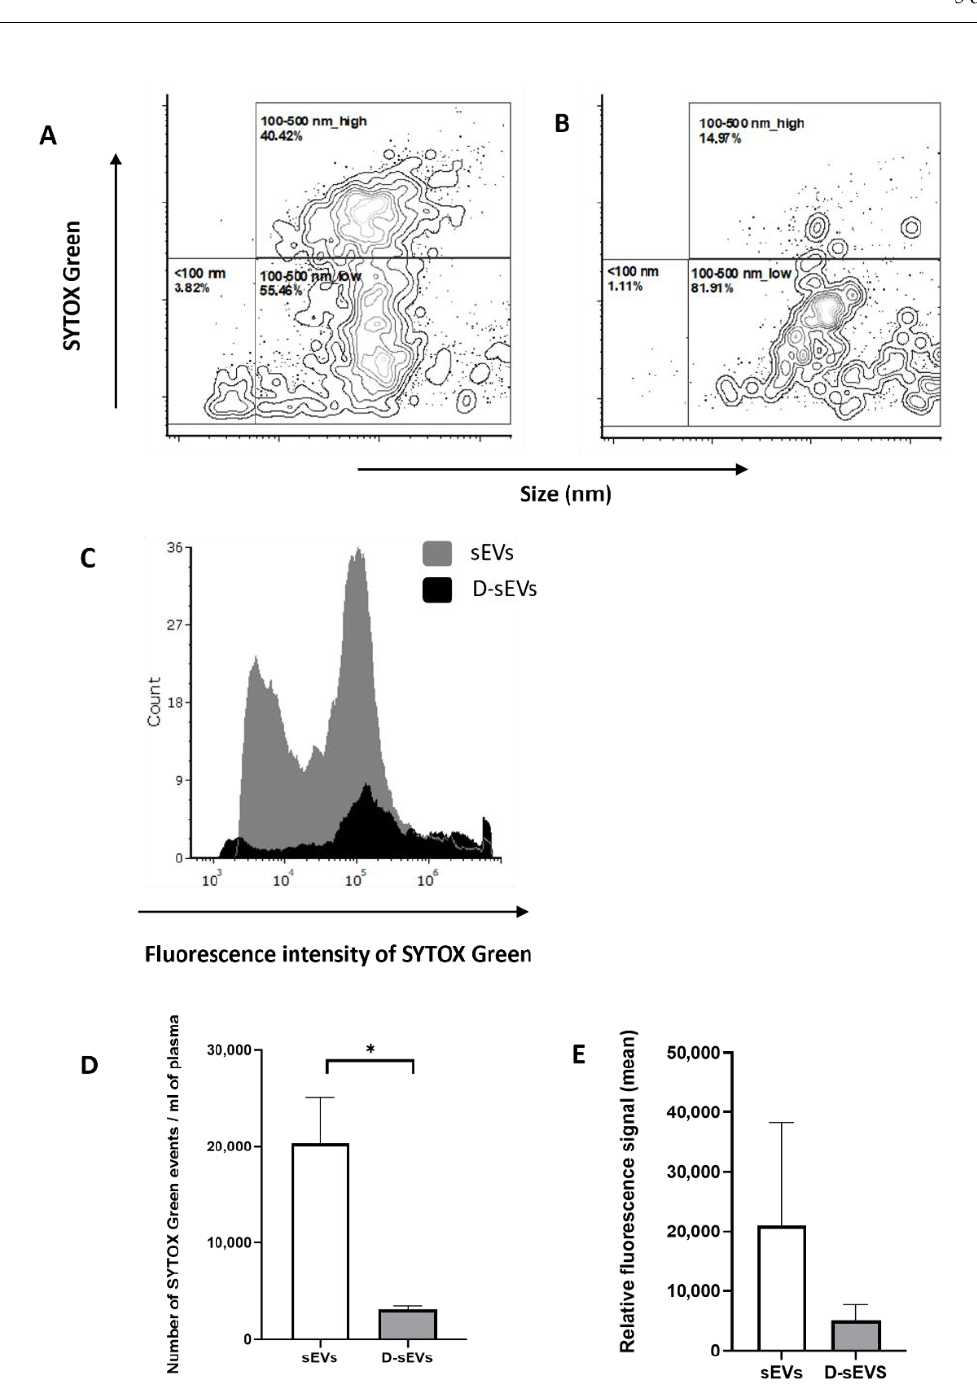
Figure 3. Flow cytometry of sEVs. ( A ) sEVs isolated from fresh human plasma without DNase; ( B ) Dplas-sEVs–sEVs isolated from fresh human plasma with the addition of DNase; ( C ) overlay histogram of sEVs isolated from fresh human plasma with and without DNase; ( D ) number of detected events per ml of plasma; ( E ) relative fluorescence signal of ecDNA stained with SytoxGreen. Data are shown as the mean ± SEM. Significance was assumed at p < 0.05. * p < 0.05. sEVs–EVs isolated from fresh human plasma without DNase; D-sEVs–sEVs treated with